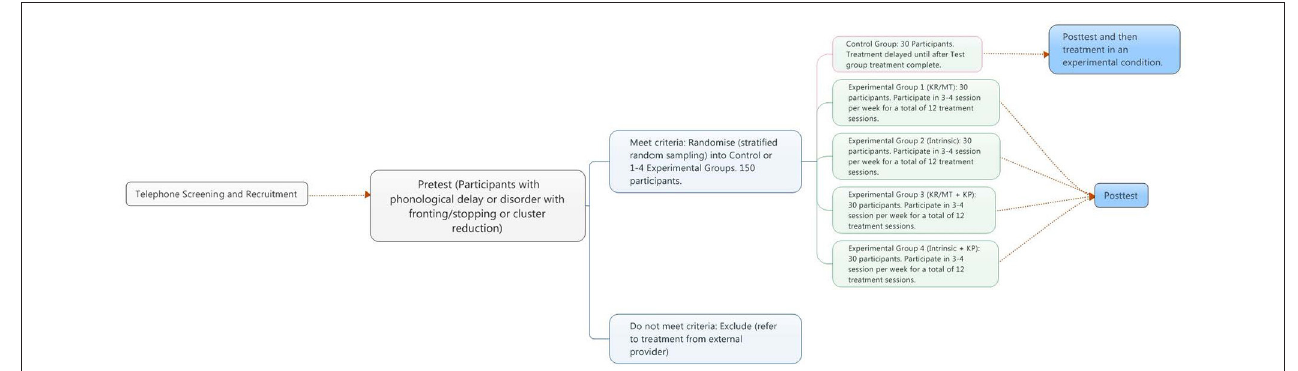
FIGURE 4 | Session